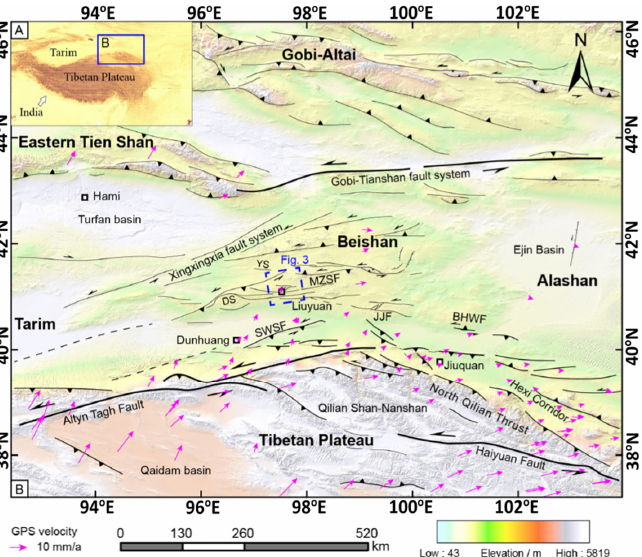
Figure 2. Structural geology map around Beishan [20] highlighting the locations of Beishan, Tarim Basin, Aerjin Fault System (Altyn Tagh Fault), and Qilian Mountains. The study area is indicated by the blue dashed outline, labelled Figure 3.